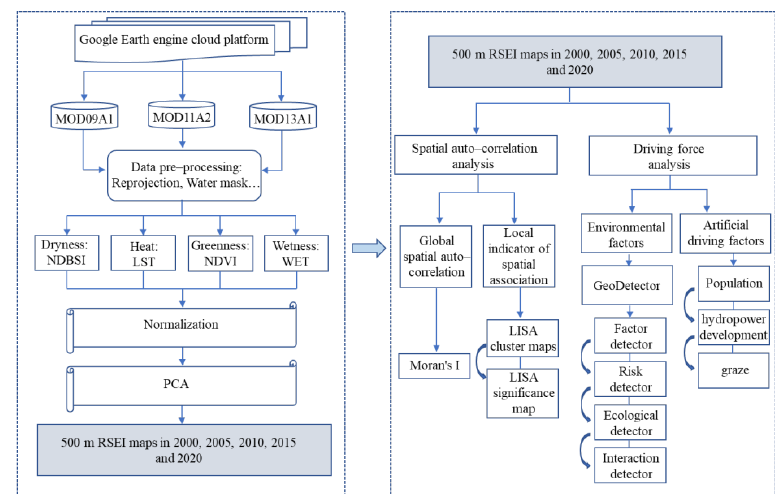
Figure 2. Study workflow.